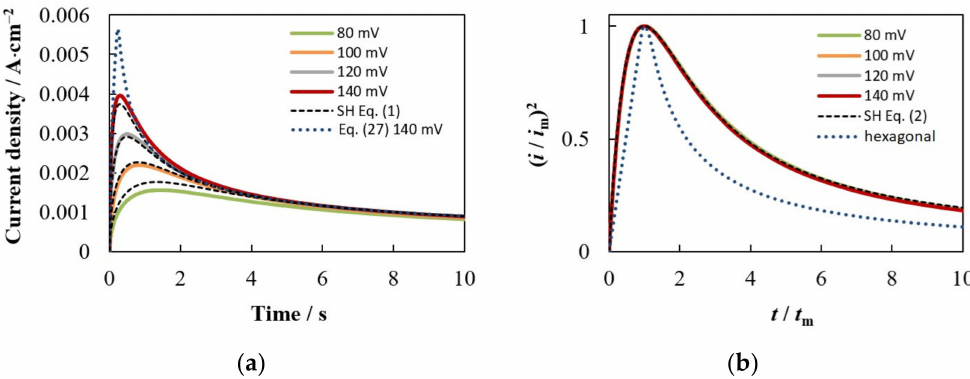
Figure 5. ( a ) Comparison of current density transients from Figure 4a with models based on the concept of planar diffusion zones for random (Equation (1)) and hexagonal (Equation (27)) ensembles; ( b ) Comparison of the same curves in dimensionless